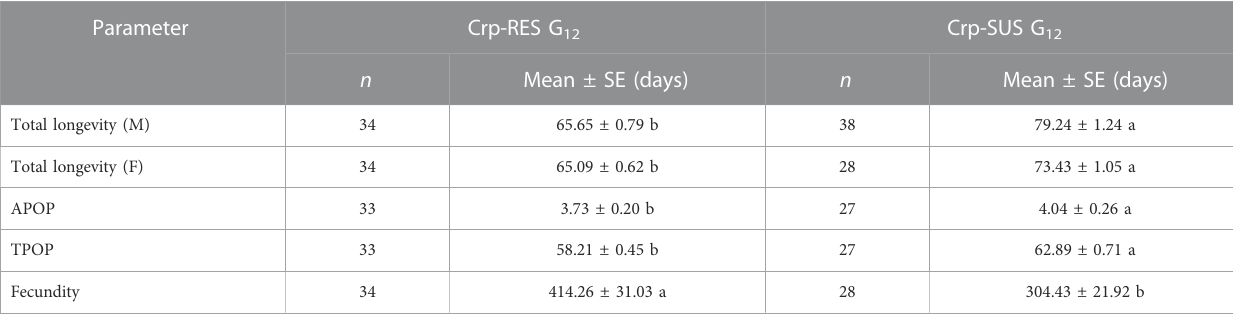
TABLE 4 Adult longevity and female fecundity for the Crp-RES G 12 and Crp-SUS G 12 strains. Parameter